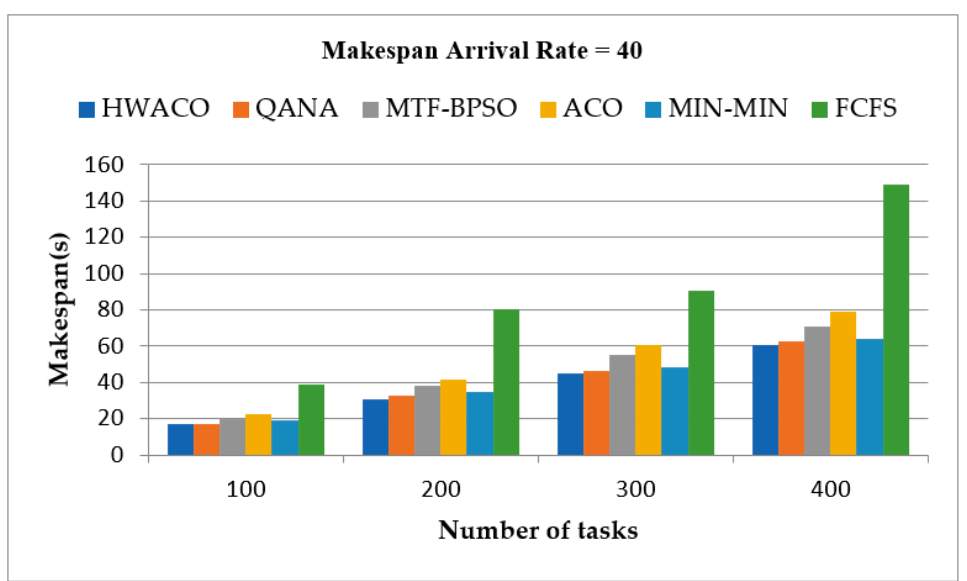
Figure 3. Execution time for the tasks with onset rate of 40.